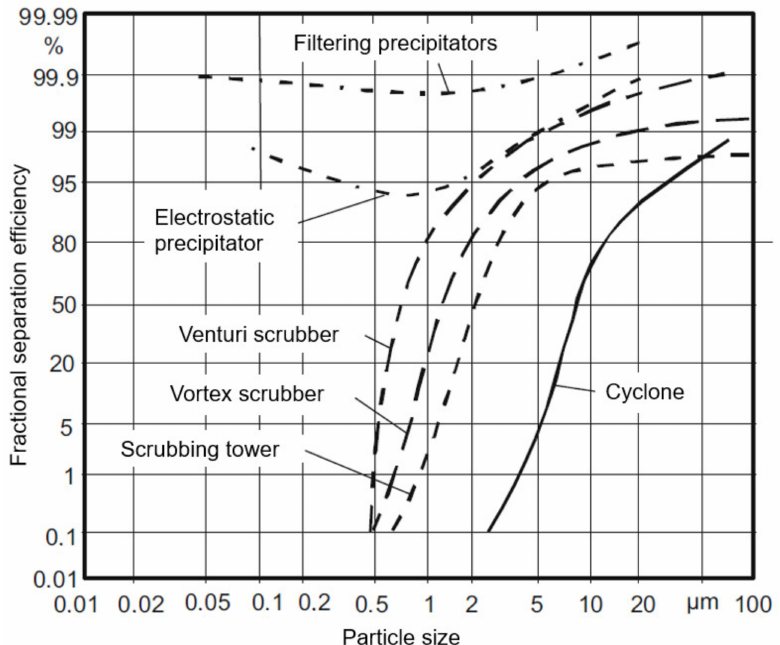
Figure 20. PM emission conversion efficiencies of different separation technologies by particle size [37] (translated into English). Reprint with permission from Gaderer, M. et al. (2016). Direkte thermo-chemische Umwandlung (Verbrennung). In: Kaltschmitt, M., Hartmann, H., Hofbauer, H. (eds) Energie aus Biomasse; Copyright 2016, Springer Vieweg, Berlin,